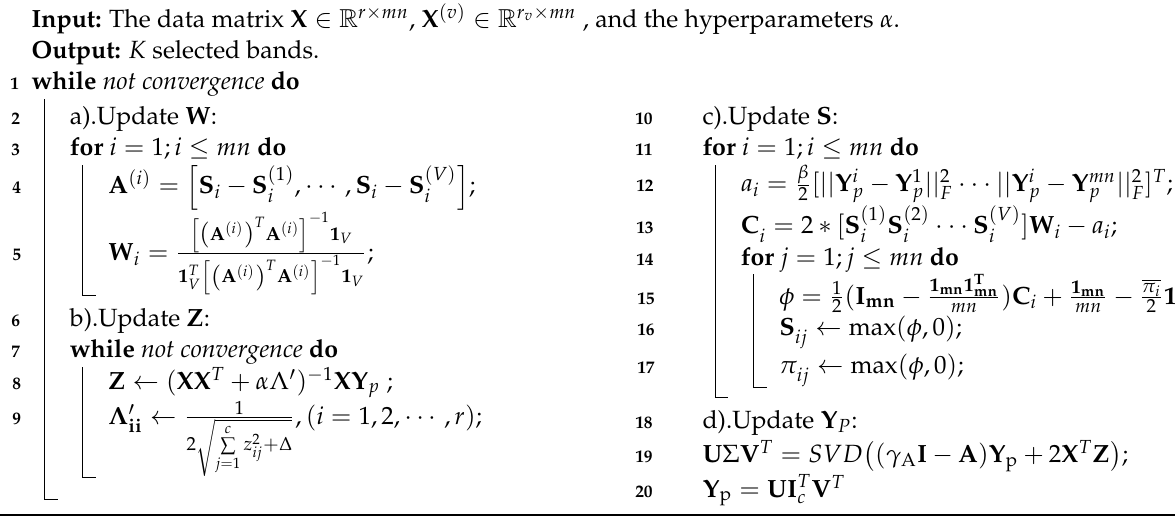
Algorithm 1: Alternative iterative algorithm to solve Equation